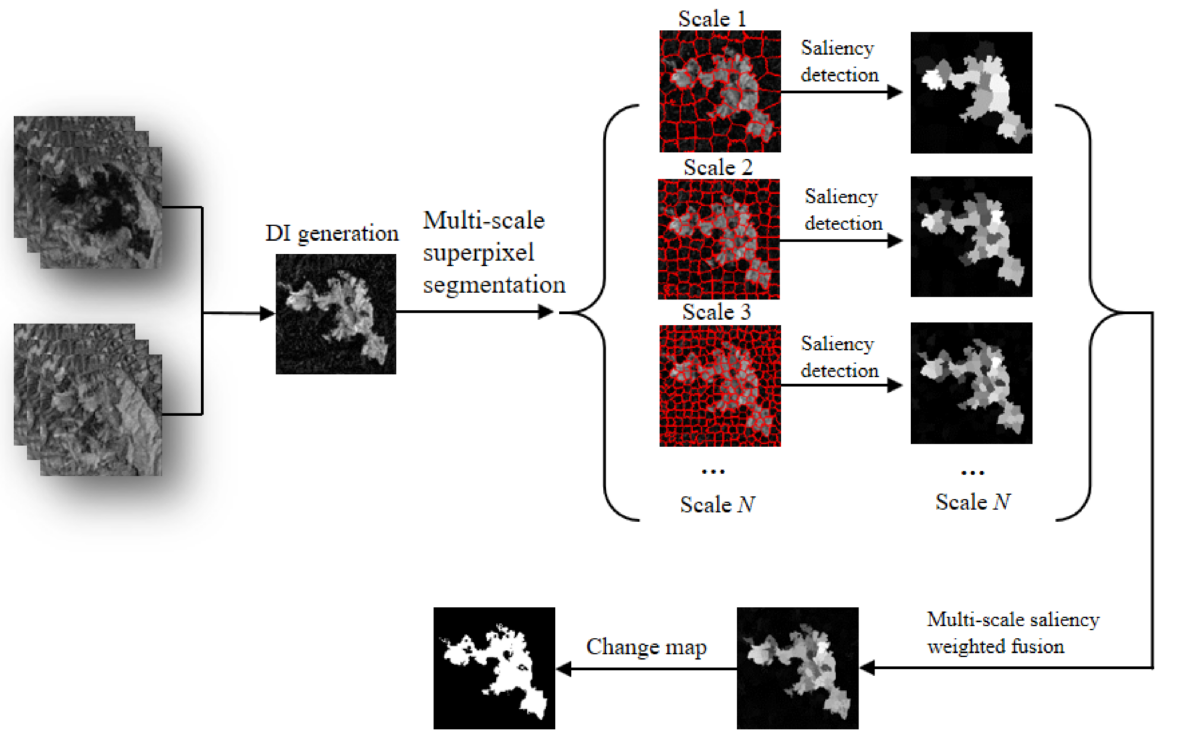
Figure 1. Flowchart of the proposed